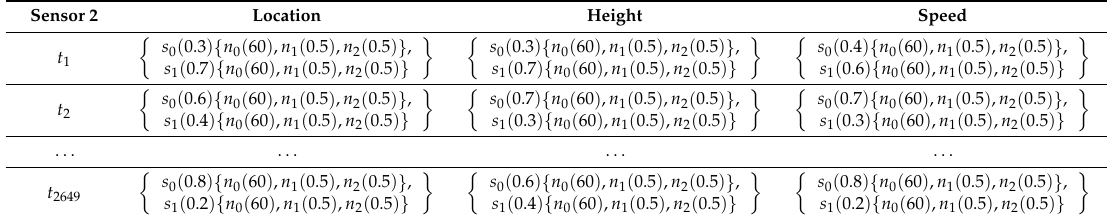
Table 4. Part of the individual evaluation matrix of sensor 2.